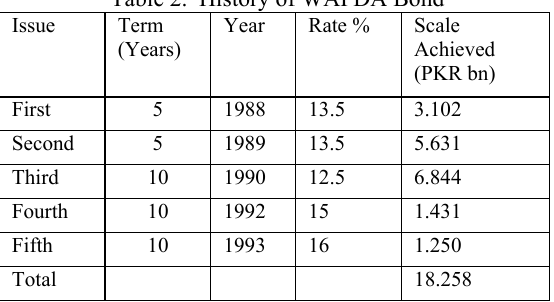
Table 2. History of WAPDA Bond